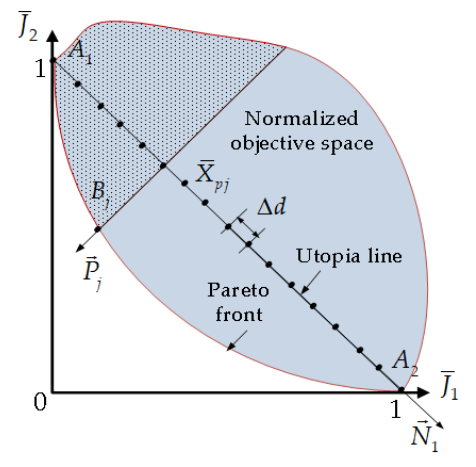
Figure 4. Pareto front, Utopia line, and normalized objective